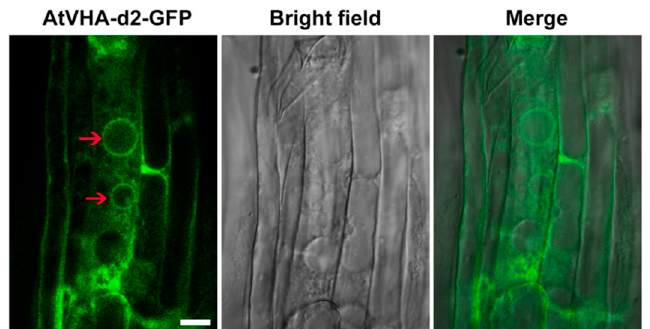
Figure 3. Subcellular localization of AtVHA-d2-GFP in Arabidopsis . Green fluorescent protein (GFP) fluorescence is green. Merge was created by merging the GFP and bright-field images. The red arrows indicate small vacuoles. Scale bar = 10 µm.